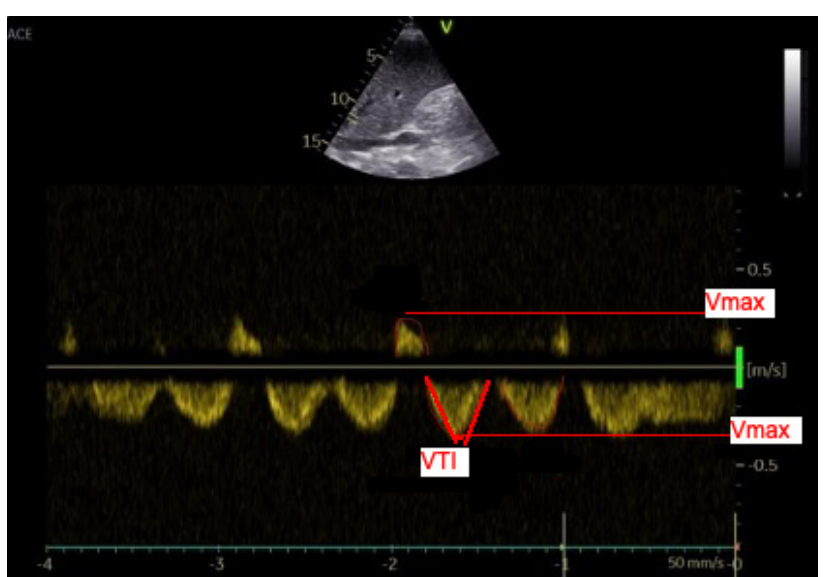
Figure 1. Flow chart.